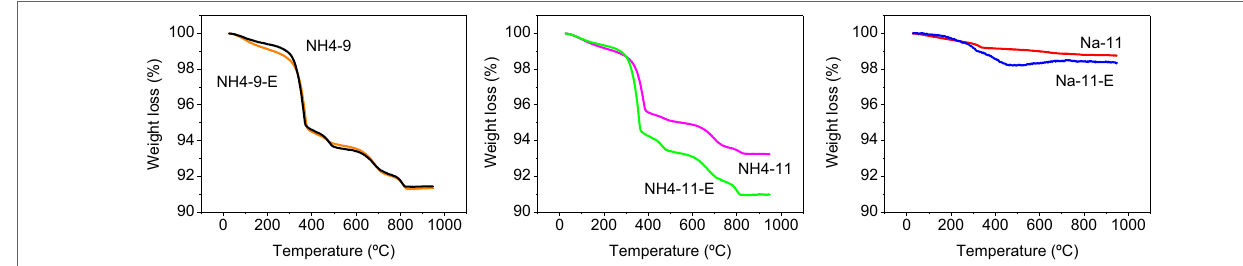
FigUre 5 | Thermogravimetric analysis profiles of fresh calcined samples.